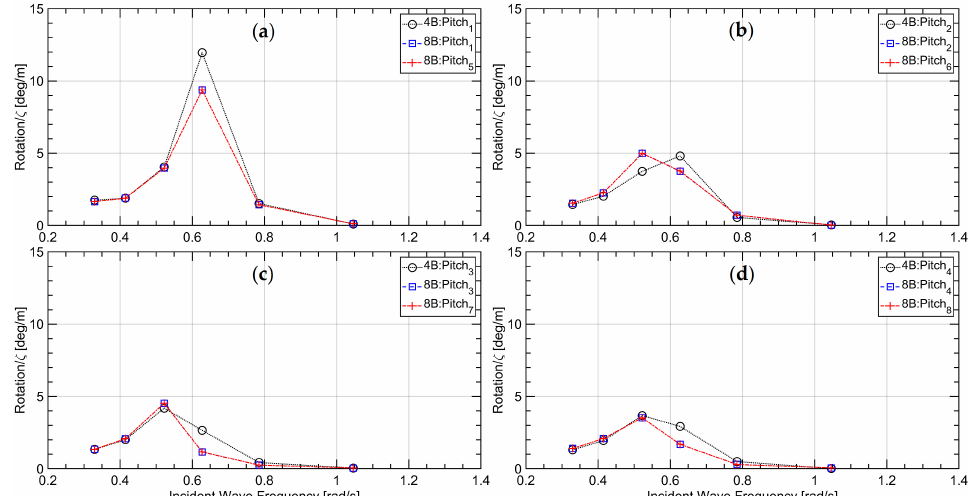
Figure 19. RAOs of pitch response studying the sensitivity to module arrangement, where n B denotes the configuration with n bodies; subscript n , the corresponding n -th body’s motion response: ( a ) the 1st and 5th modules; ( b ) the 2nd and 6th modules; ( c ) the 3rd and 7th modules; ( d ) the 4th and 8th modules.